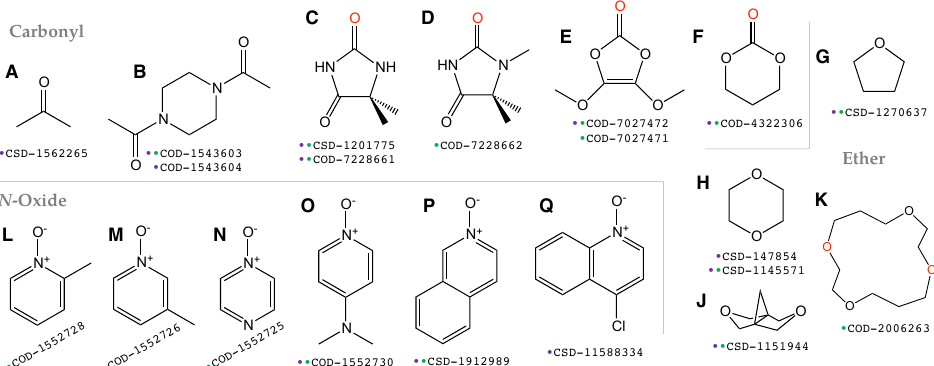
Figure 1. Structures of the 16 halogen bonding acceptor molecules investigated in this work. In any structure with two or more oxygen atoms, the oxygen participating in I · · · O halogen bonding is colored in red. Below each 2D molecular structure is the COD/CSD id number for the crystal structure(s) from which the acceptor molecule was extracted or adapted. The colored dot in front of the COD/CSD id number indicates that the model crystal structure containing the present acceptor molecule associated with diiodine (I 2 ; purple dot) or iodine monochloride (ICl; green dot) was calculated in this